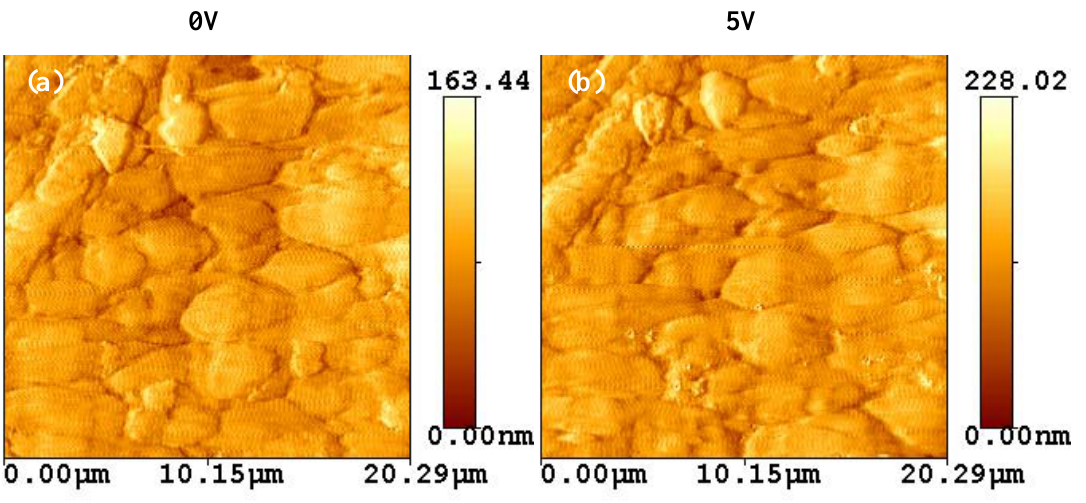
Figure 5. The texture change of a PVDF surface. The PVDF sample of 110µm thickness with 600Å NiCu coated was characterized for its surface with external electrical potentials, 0V (a) and 5V